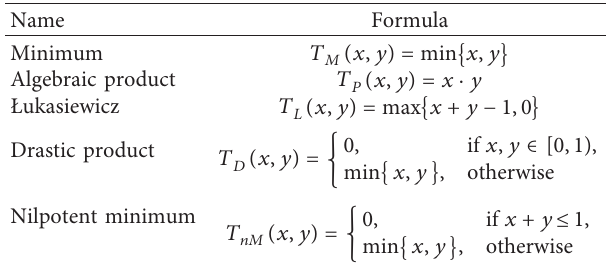
Table 3: Basic fuzzy